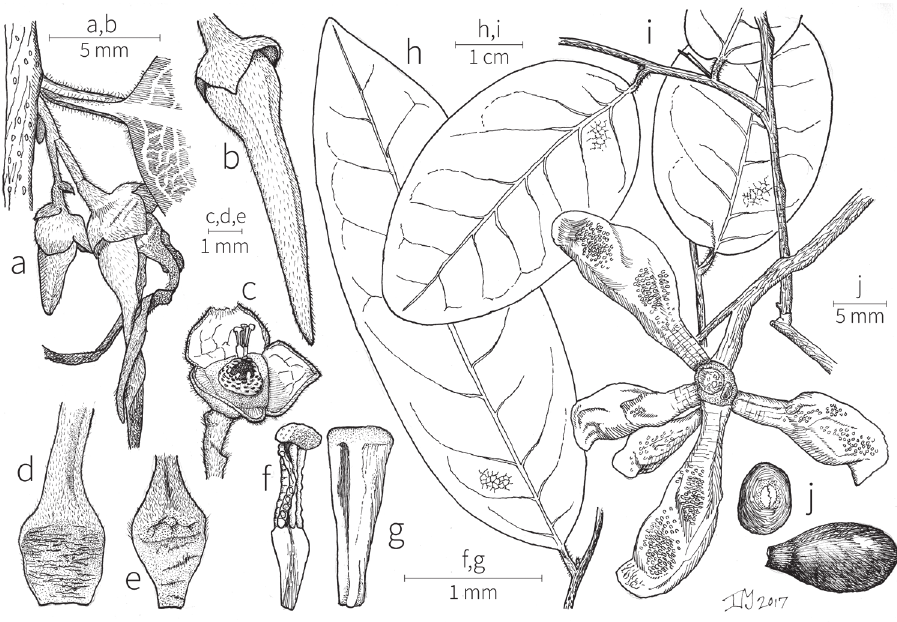
Figure 29. Xylopia nilotica . A Close-up of inflorescence, showing two pedicels branching from the same peduncle B Flower bud, lateral view C Receptacle with petals, stigmas, and most of the stamens fallen, showing staminal cone D Base of outer petal, adaxial view E Base of inner petal, adaxial view F Fertile stamen, abaxial view G Outer staminode, abaxial view H Leaf I Habit, including leaves and fruit J Seed, view of micropylar end and side view. A, H from Greenway & Eggeling 7251 (K) B from Wood 610